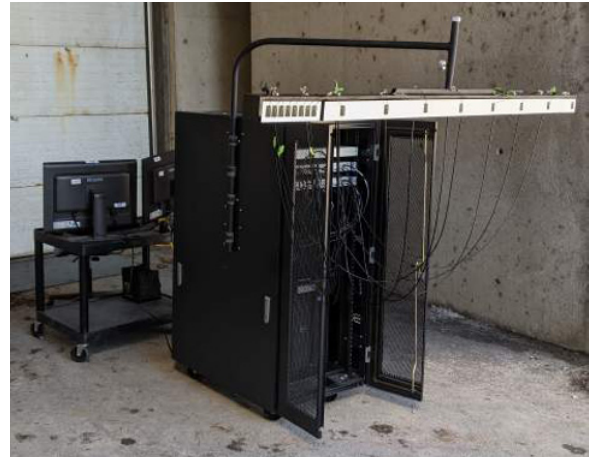
Figure 9. Photo of the final MIMO Radar during testing